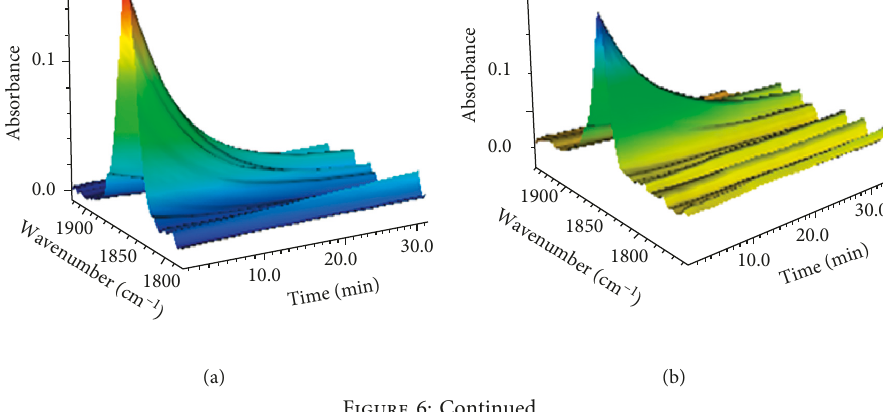
(c) complexes (1: control, without −